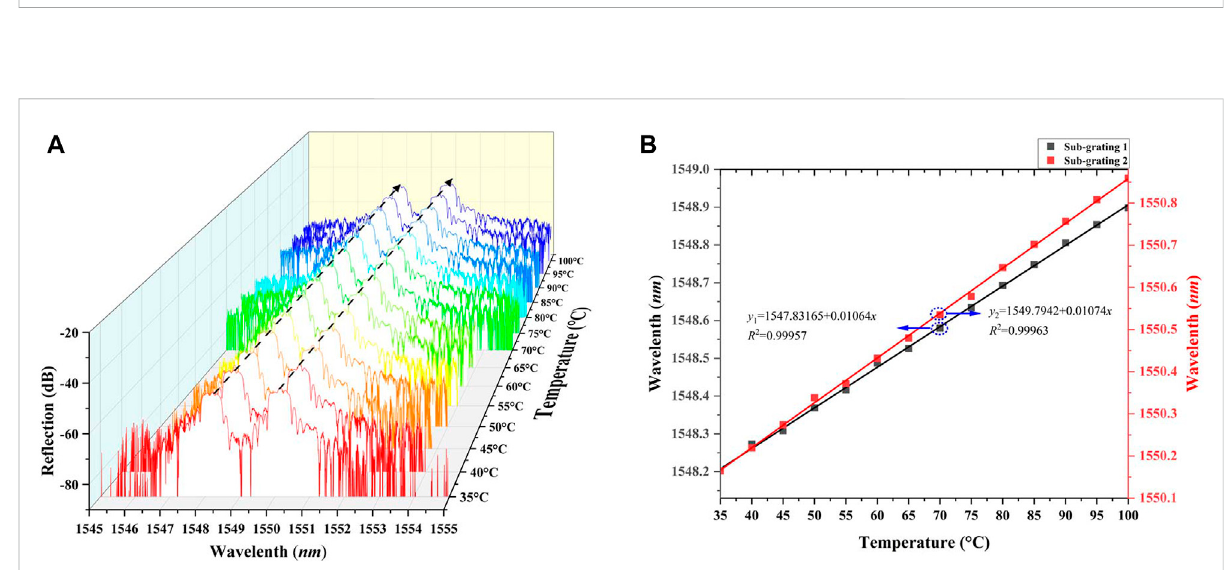
FIGURE 4 Resultsofthetemperaturesensingexperiment. (A) Re fl ectionspectraof2DFBGatdifferenttemperatures. (B) Thecenterwavelengthandlinear curve fi tting results of the two sub-gratings of 2D FBG at different temperatures.